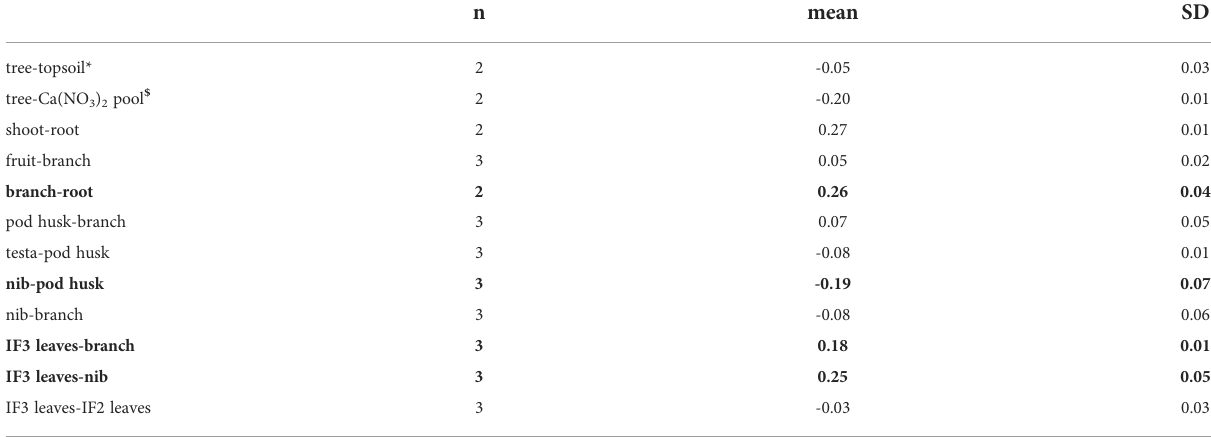
TABLE 3 Apparent Cd isotope fractionation D 114/110 Cd A-B in the cacao tree with SD of three biological replicates.